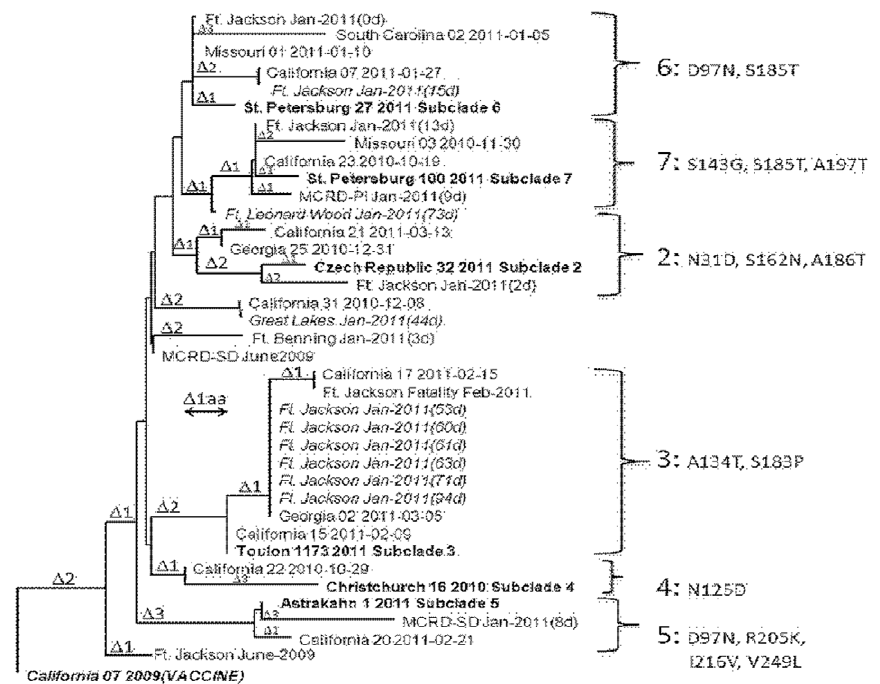
Figure 4. Phylogenetic analysis of the hemagglutinin (HA) gene of influenza pH1N1 isolates. The phylogenetic tree was constructed using the neighbor-joining method (CLUSTAL W method) of the MegAlign program (Lasergene software suite, DNASTAR Inc., Madison, WI). The tree represents amino acids 111 through 360 of the mature HA protein. Reference strains for the six circulating subclades (2–7) are shown in bold text, with their defining mutations shown to the right. The vaccine strain, A/CA/7/2009, is shown in bold and italicized. Isolates collected by NHRC from recruits who had been vaccinated greater than 14 days are italicized. Strains from the same geographical location and time of collection from the GISAID database are included in the tree as well as two samples collected from the same recruit training sites in 2009. The scale indicates the distance created by a one amino-acid difference between sequences. The number of amino acid changes between subclades is denoted by a delta symbol ( D ).